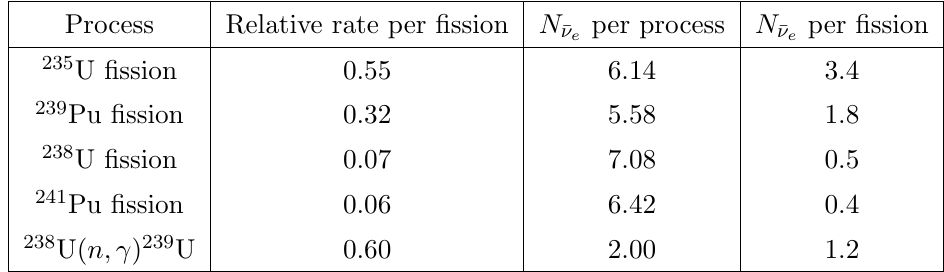
Table 3 . Typical relative (cid:12)ssion contribution and (cid:22) (cid:23) e yield for each process considered [40]. The total antineutrino (cid:13)ux as function of the energy at the CONNIE detector, in units of number of antineutrinos per MeV per cm 2 per second, is given by